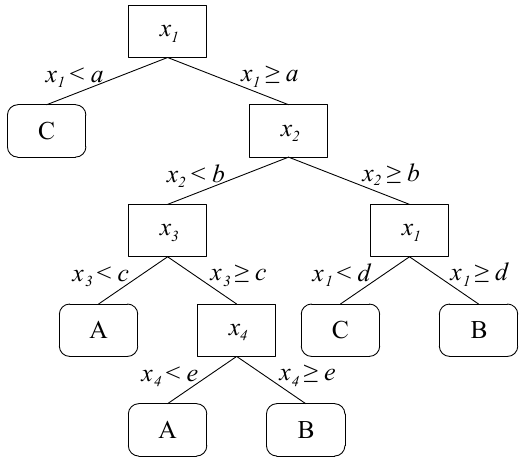
Figure 2. Structure of a decision